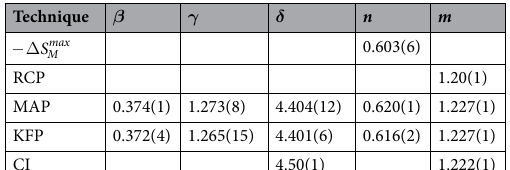
where T r 1 and T r 2 are the temperatures of two reference points corresponding to Δ = Δ S T T S ( , the −Δ S M ( T , H ) curves collapse onto a single curve regardless of temperature and field, as shown in Fig. 4(c). In the phase transition region, the scaling analysis of −Δ S M can also be expressed as ε −Δ = M 1/ M where a M = T c − 1 A δ + 1 B with A and B representing the critical amplitudes as in M s ( T ) = A ( − ε ) β and H = BM δ , Δ = β + γ , and f ( x ) is the scaling function 38 . If the critical exponents are appropriately chosen, the −Δ S M ( T ) curves should be rescaled into a single curve, consistent with normalizing all the −Δ S M curves with two refer- ence temperatures. By using the values of β = 0.372 and γ = 1.265 obtained by the Kouvel-Fisher plot 14 , we have replotted the scaled −Δ S M for Fe 3 − x GeTe 2 [Fig. 4(d)]. The good overlap of the experimental data points clearly indicates that the obtained critical exponents for Fe 3 − x GeTe 2 are not only in agreement with the scaling hypoth- esis but also intrinsic.